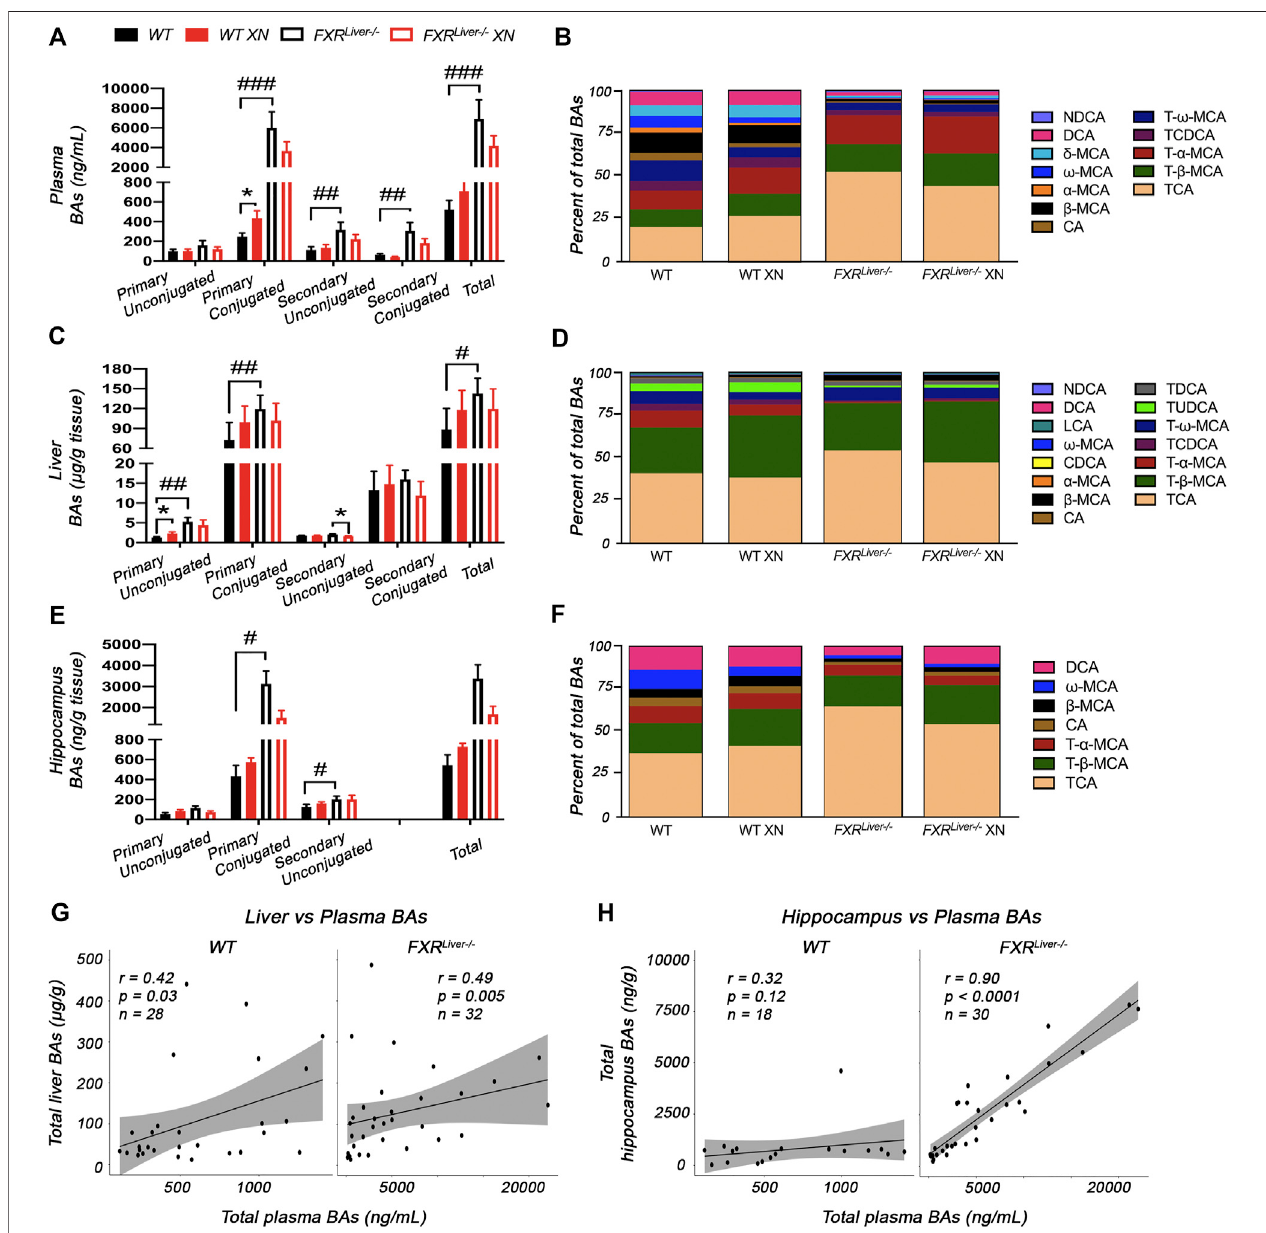
FIGURE 3 | XN modulates BA composition (A) Total BAs and (B) composition of the BA pool in the plasma ofHFD-fed WT and FXR Liver − / − mice (C) Total BAs and (D) compositionofBAsintheliverofHFD-fedWTandFXR Liver − / − mice (E) TotalBAsand (F) compositionofBAsinthehippocampusofHFD-fedWTandFXR Liver − / − mice (G) Correlations between liver and plasma BAs in WT and FXR Liver − / − mice (H) Correlations between hippocampus and plasma BAs in WT and FXR Liver − / − mice. Bar graphs values are mean ± SEM (n (cid:2) 15 – 18 per group). * p < 0.05, ** p < 0.01, *** p < 0.001 for effect of XN treatment; # p < 0.05, ## p < 0.01, ### p < 0.001 for genotype comparison. Abbreviations: chenodeoxycholic acid (CDCA), cholic acid (CA), deoxycholic acid (DCA), lithocholic acid (LCA), muricholic acid